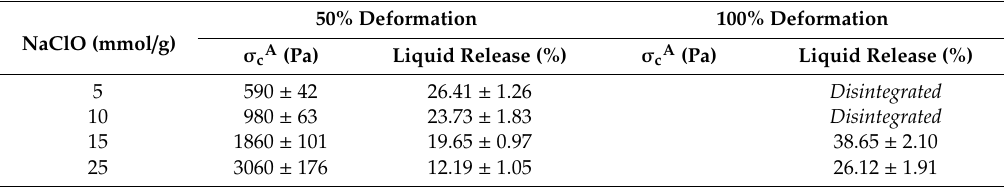
Table 3. Compression test at 50% and 100% deformation of the di ff erent